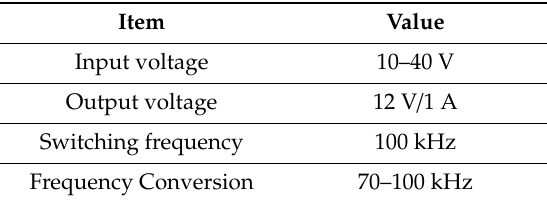
Table 1. Circuit specifications.